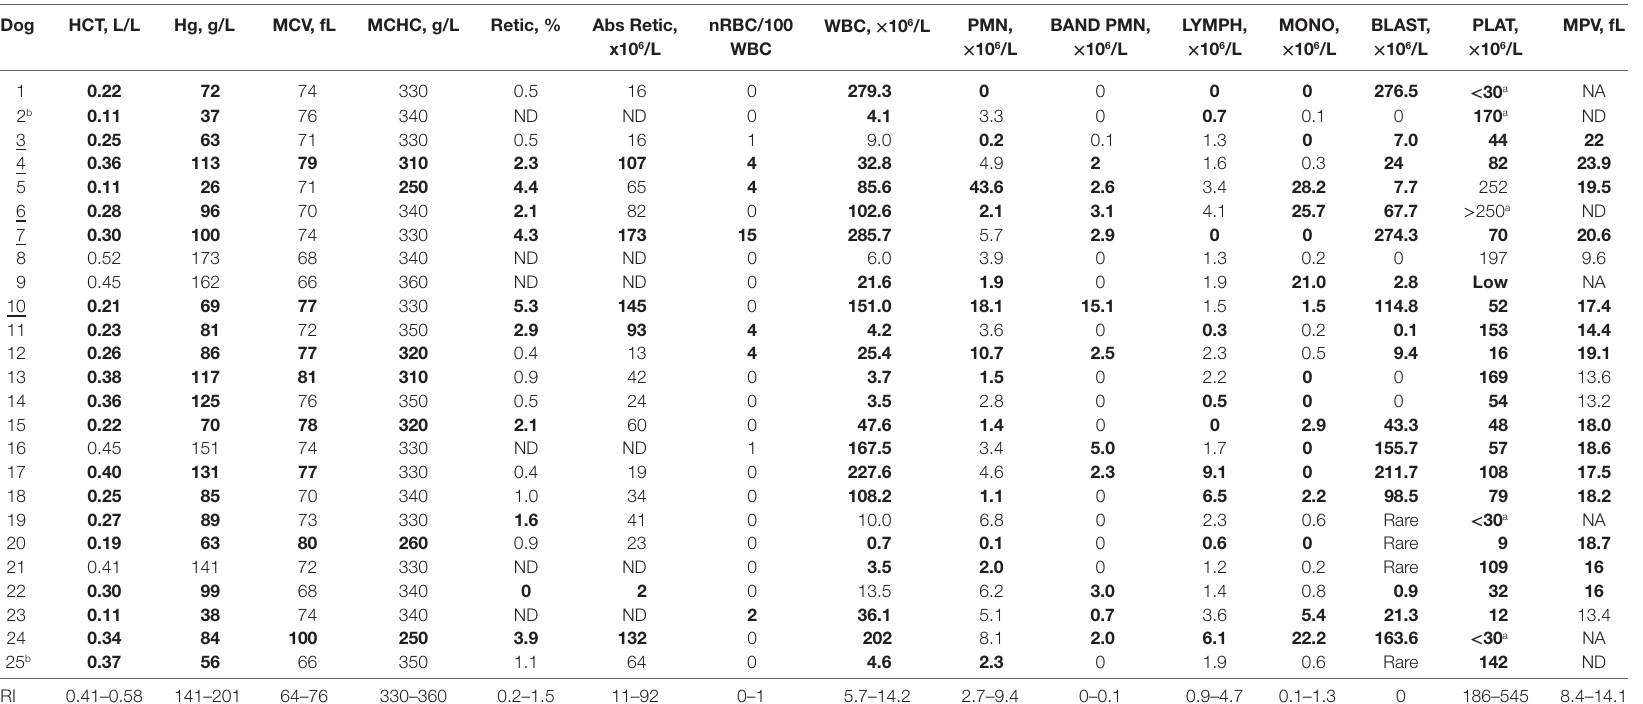
TaBle 5 | hematologic findings in 25 dogs with acute myeloid leukemia in which clonality testing was performed. Dog hcT, l/l